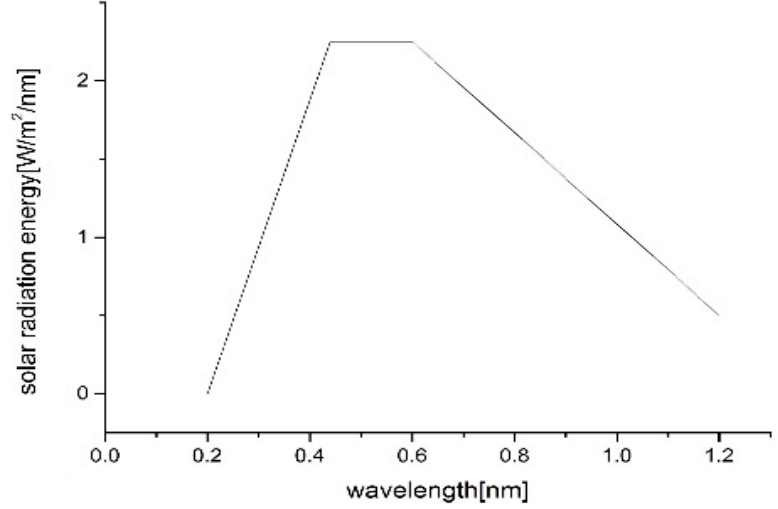
Figure 10. The approximate curve of actual solar radiation energy on the Earth’s surface from 200 nm to 1200 nm.